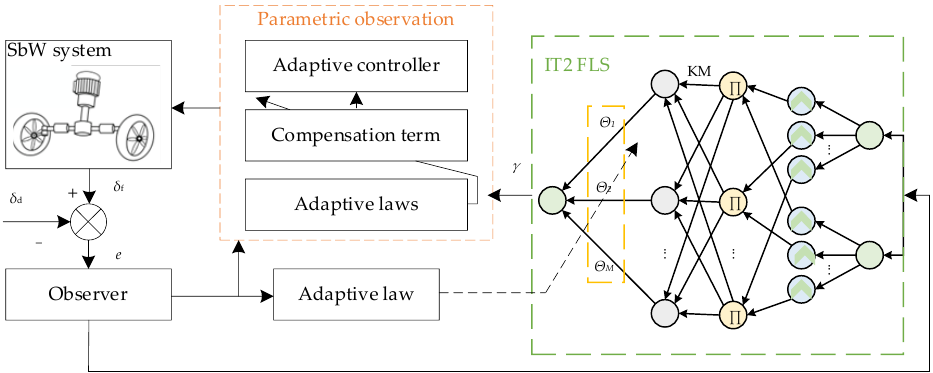
Figure 12. Observer-based adaptive interval type two fuzzy logic system controller [81].